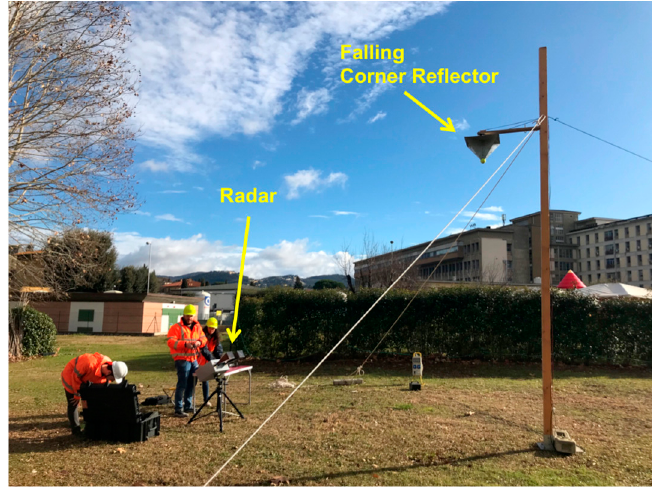
Figure 11. Picture of the experimental set-up for detecting a free-falling corner reflector by radar.